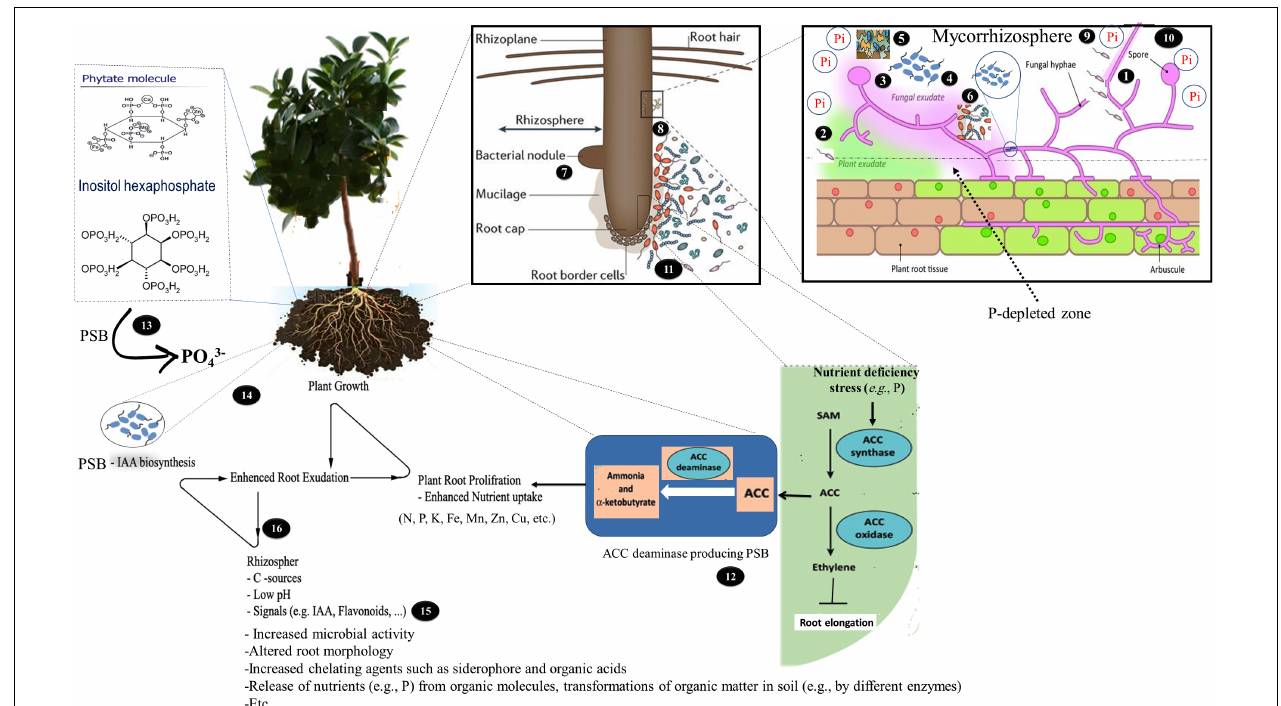
FIGURE 2 | A schematic representation of how the interaction between arbuscular mycorrhizal fungi (AMF) and phosphate-solubilizing bacterium (PSB) affect the host plant’s utilization of the organic and inorganic phosphorus (P). (1) PSB use the hyphae to access greater soil volumes further away, which can benefit the fungi as phosphorus solubilizers may grow into insoluble-phosphorus-containing patches away from the route along the AMF hyphae; (2) PSB can colonize the rhizosphere (potentially rich with resources from plant exudates) by using the AMF hyphae to allow growth in other directions towards the plant; (3) AMF can supply energy-rich carbohydrates (C) via the extraradical hyphae for PSB; (4) the fungal exudates can change the rhizospheric pH, influence the chemical composition of the root exudates, and increase microbial activity; (5) AM hyphae and mycelial exudates can improve soil structure by binding to soil particles and through glomalin production, which may glue soil particles together and subsequently affect soil moisture retention; (6) AMF colonization can influence the bacterial community compositions in the mycorrhizosphere; (7) AMF can increase the ability of legumes to fix N 2 and reduce the amount of inorganic nitrogen that leaches, increasing plant growth and subsequently enhancing root exudates; (8) PSB can stimulate the AMF colonization; (9) AMF, unlike root hairs, can extend much farther away from the root surfaces. In other words, the extraradical hyphae extend beyond the phosphorus depletion zone, to absorb the bioavailable phosphates that are otherwise inaccessible for plants. In addition, AMF-solubilized phosphates and bacteria are more efficiently taken up by plants through a mycorrhizal-mediated channel between the plant roots and the surrounding soil; (10) AMF can take up and transfer inorganic phosphorus to the roots by their effective mycorrhizal mycelium, reaching microhabitats where orthophosphates are made available with phosphorus-mobilizing microorganisms and preventing quick immobilization of orthophosphates by microbial biomass; (11) PSB can improve the nitrogen and phosphorus availability for AMF and plants through organic matter decomposition; (12) PSB (ACC deaminase positive), by synthesizing ACC deaminase, can lower the stress ethylene levels, which is involved in stimulating the growth of AMF; (13) PSB can increase the AMF hyphal growth by hydrolyzing organic phosphorus with secretion of enzyme phosphatases and phytases and providing mineral phosphorus for the fungi; (14) PSB (IAA positive) can increase the IAA levels, resulting in more lateral roots that form the preferred penetration sites for AM hyphae. In addition, AMF can use the IAA the related compounds as a part of their colonization strategy to interact with plants, which leads to stimulated plant growth and modified basal plant defense mechanisms; (15) PSB can promote the induce flavonoid release from plants to promote mycorrhiza formations, thus facilitating root colonization; and (16) PSB (IAA positive) can loosen plant cell walls to promote root exudation to provide additional nutrients that support the microbial growth of